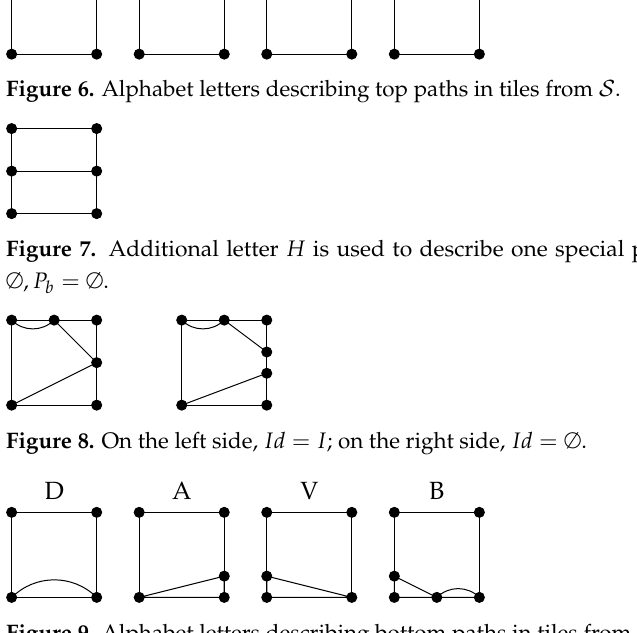
Figure 9. Alphabet letters describing bottom paths in tiles from S .